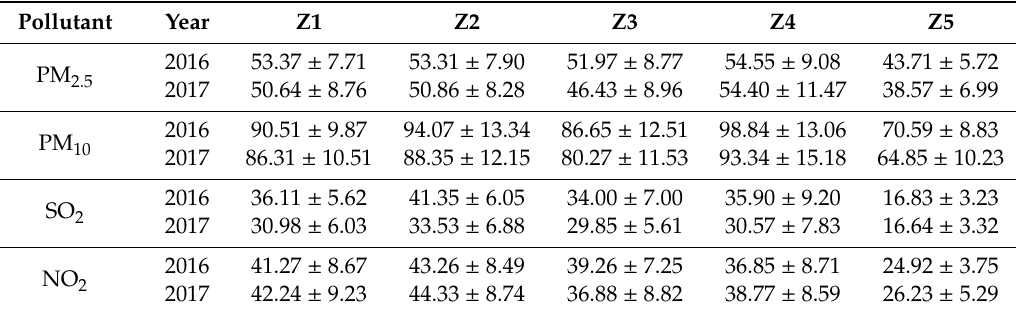
Table 2. Mean ( ± SE) annual concentrations of four major air pollutants among five ecological functional zones in Shenyang from January 2016 to December 2017. Concentrations are shown in µ g · m − 3